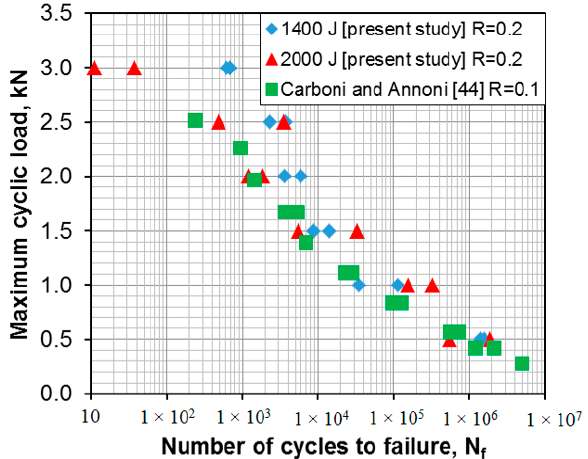
Figure 6. Fatigue life curves of the USWed 6022-T43 Al alloy joints made at a welding energy of 1400 J and 2000 J, respectively, and tested at RT, R = 0.2, and a frequency of 50 Hz.